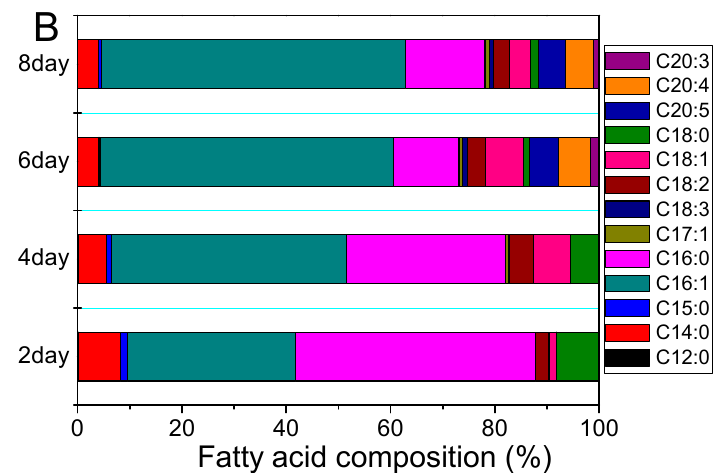
Figure 1. Growth, glucose consumption and cellular components ( A ), and fatty acid profiles ( B ) of heterotrophic T. minus in the bubble column. Values shown are averages of three replicates and error bars represent the standard deviations for the replicates.